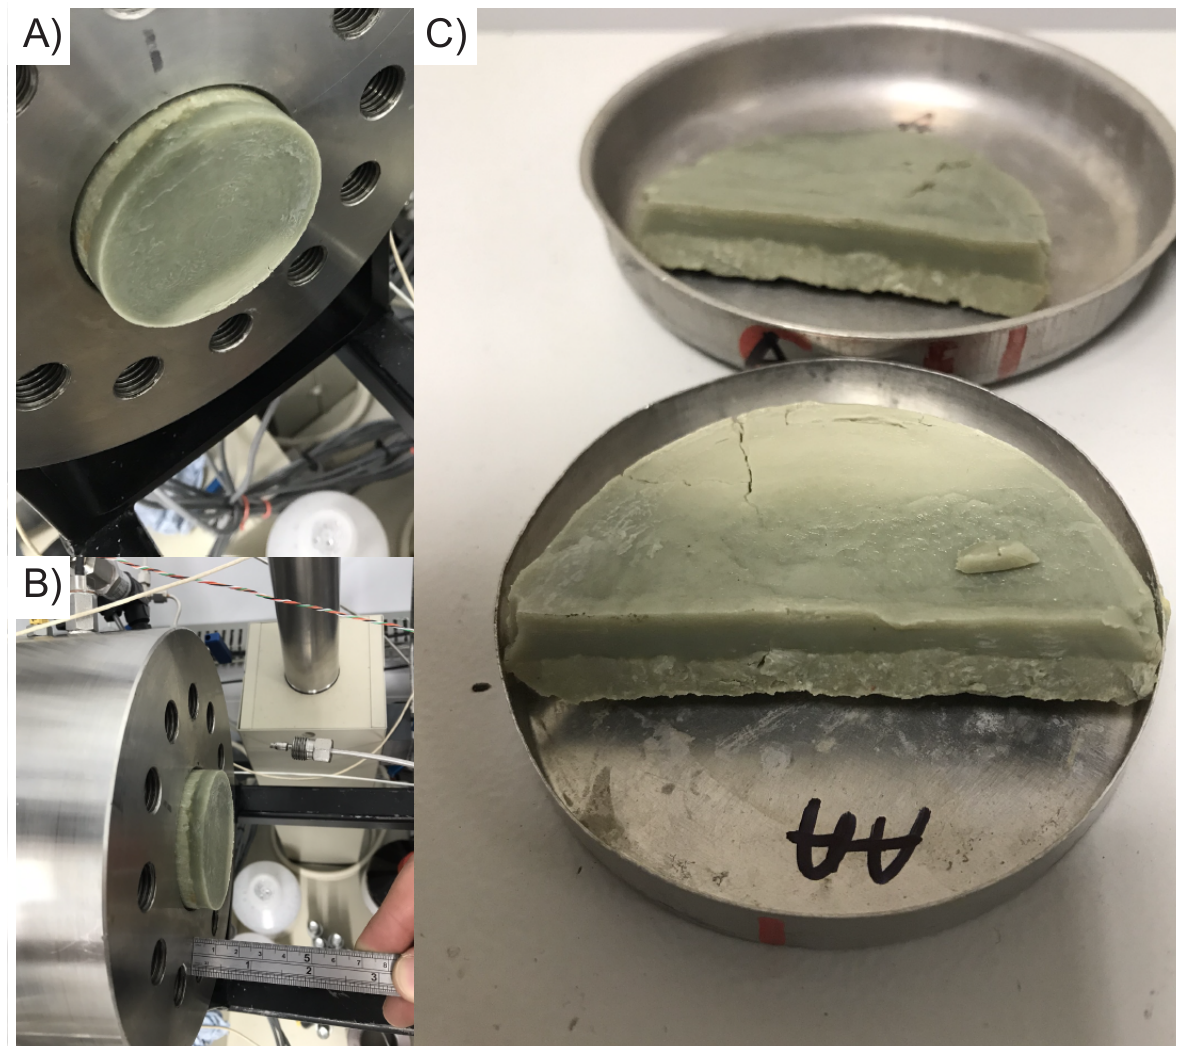
Figure 3. ( A , B ) The right-hand end of the sample being extruded from the test vessel. ( C ) Cross-section through the gel showing the top and bottom halves of the first sample